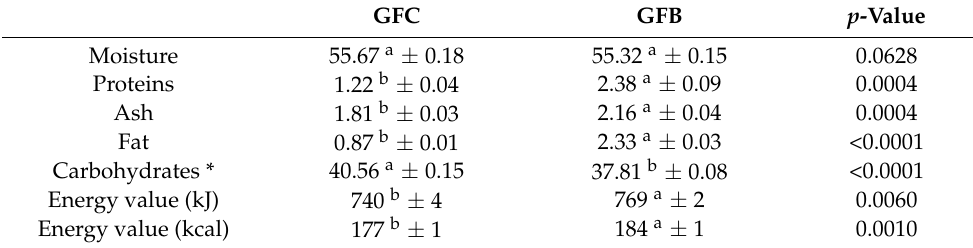
Table 2. Macronutrients content and energy value of experimental gluten-free bread. GFC GFB p -Value Moisture 55.67 a ± 0.18 55.32 a ± 0.15 0.0628 Proteins 1.22 b ±